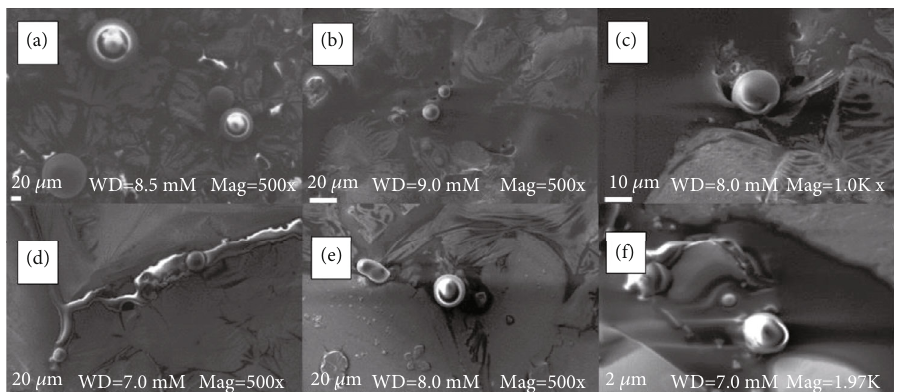
Figure 6: Morphological analysis. Images of liposomes obtained by scanning electron microscopy using an acceleration voltage of 5 kV of (a) blank, (b) sample A, (c) sample B, (d) sample C, (e) sample D, and (f) sample